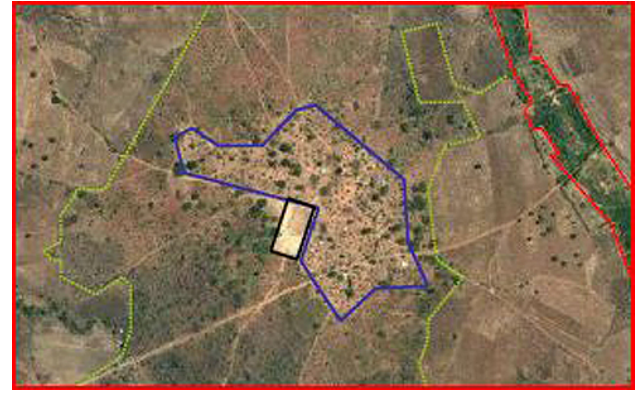
Fig. 2 . Example of a typical village in the Eastern Province (SPOT image, taken in the dry season). On higher ground, there is a settlement with thatched grass huts and some mature trees (blue outline) surrounded by common grazing land with bushes (dotted green line) that gives way to open fields of arable land, interrupted only by some individual mango trees, and in the dambo wetland there are vegetable gardens (red outline). Outlined in black is the ubiquitous football field providing a sense of scale; 50x100 m.